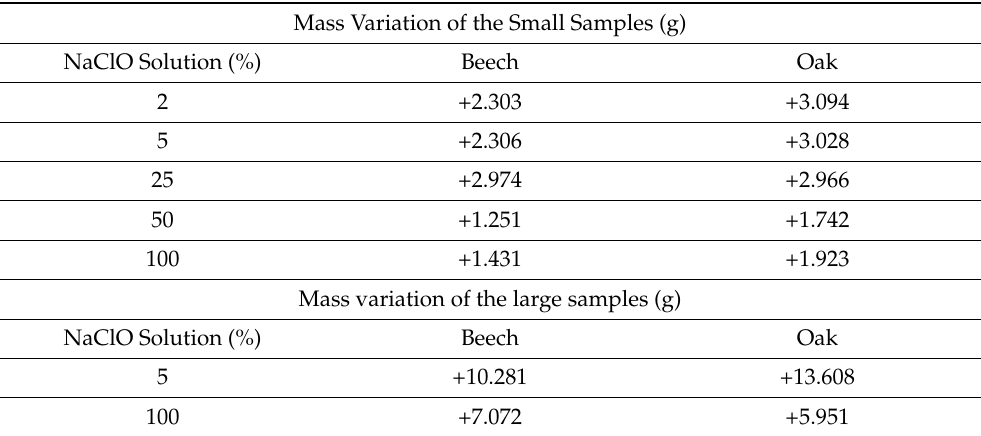
Table 4. Mass of the samples after three weeks of immersion.